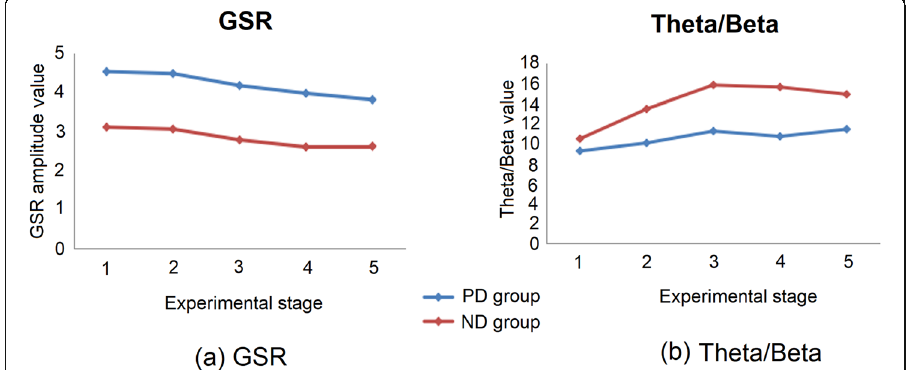
Fig. 3 Change trend graph of GSR and Theta/Beta for two